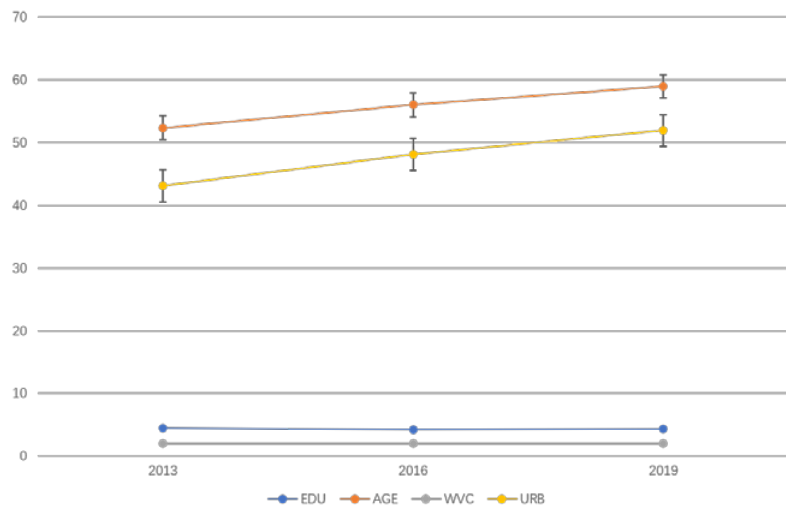
Figure 5. Three-year changes in individual and social characteristics. Table 3. Descriptive statistical results of panel data.